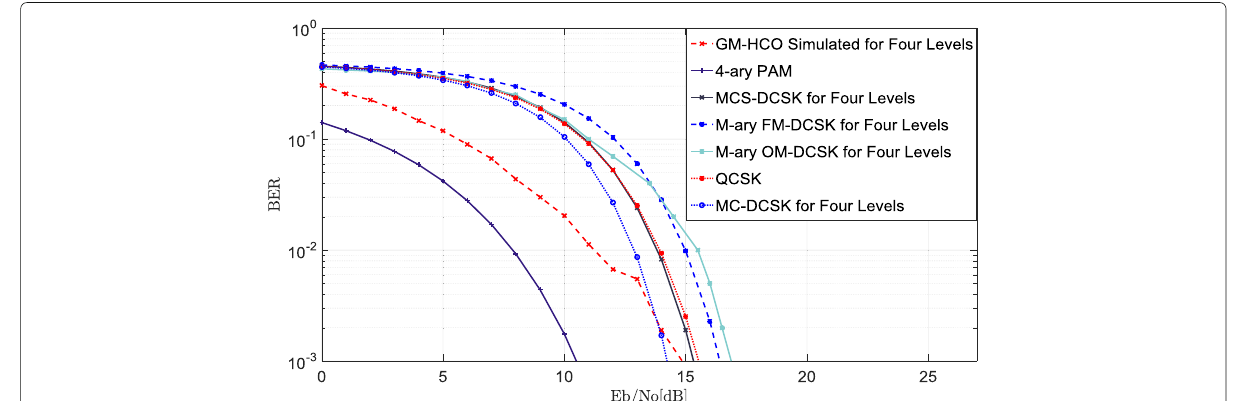
Fig. 14 BER performance of the proposed system based on GM-HCO over AWGN channel with four levels